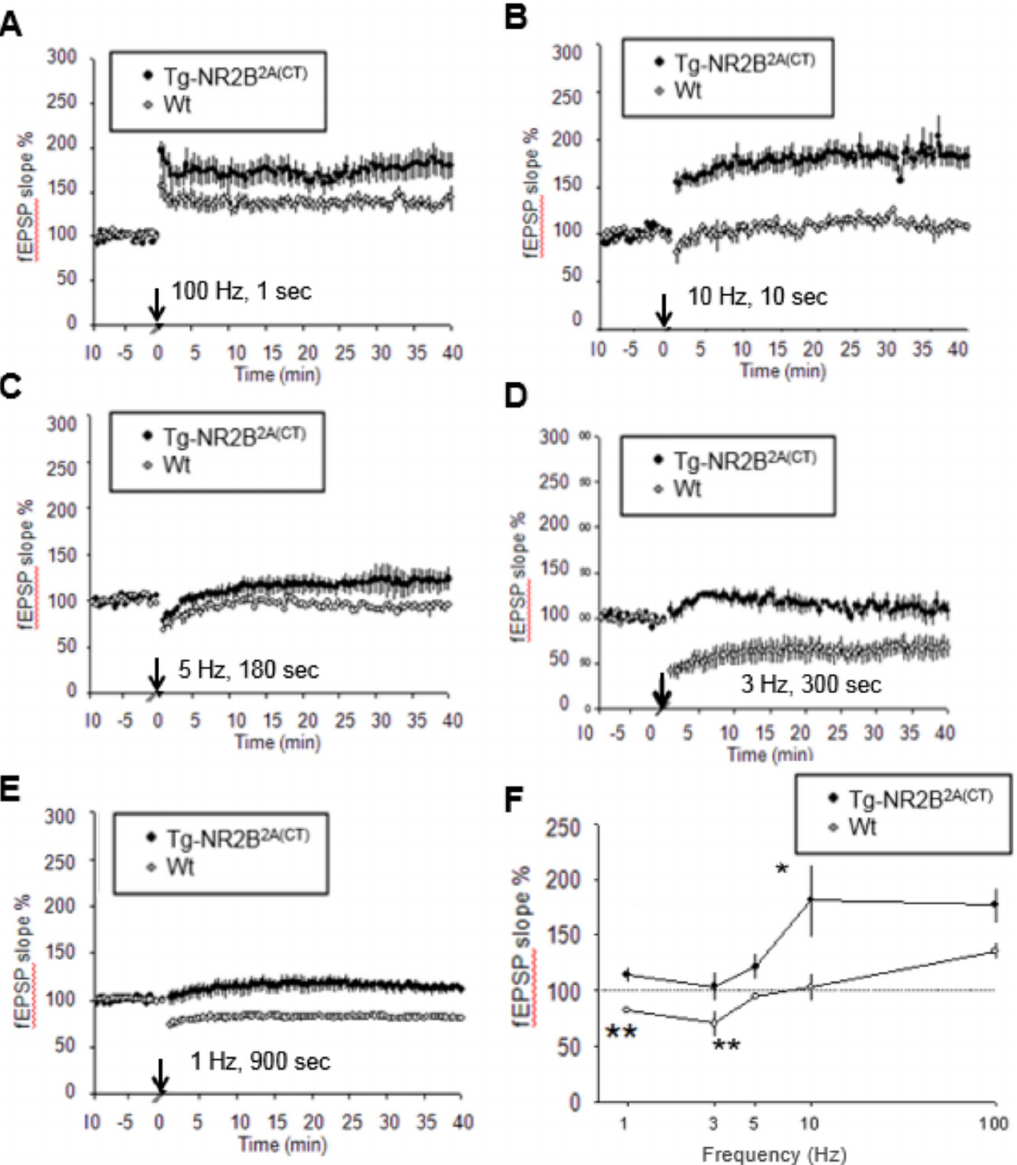
Figure 5. Enhanced LTP and diminished LTD in the Tg-GluN2B 2A(CT) mouse hippocampal slices. ( A ) A slight increase in LTP was seen in the 100 Hz stimulation protocol in the Tg-GluN2B 2A(CT) mice. ( B ) When a 10 Hz stimulation was applied for 10 s a significant increase in LTP was seen in the Tg-GluN2B 2A(CT) mice over their wild-type littermates. ( C ) LTD was diminished at 5 Hz stimulation in the Tg-GluN2B 2A(CT) mice. ( D ) LTD was significantly diminished at the 3 Hz stimulation protocol. ( E ) At the 1 Hz stimulation, the Tg-GluN2B 2A(CT) mice show significantly diminished LTD. ( F ) A summary plot of the % change in fEPSP slope versus the frequencies.